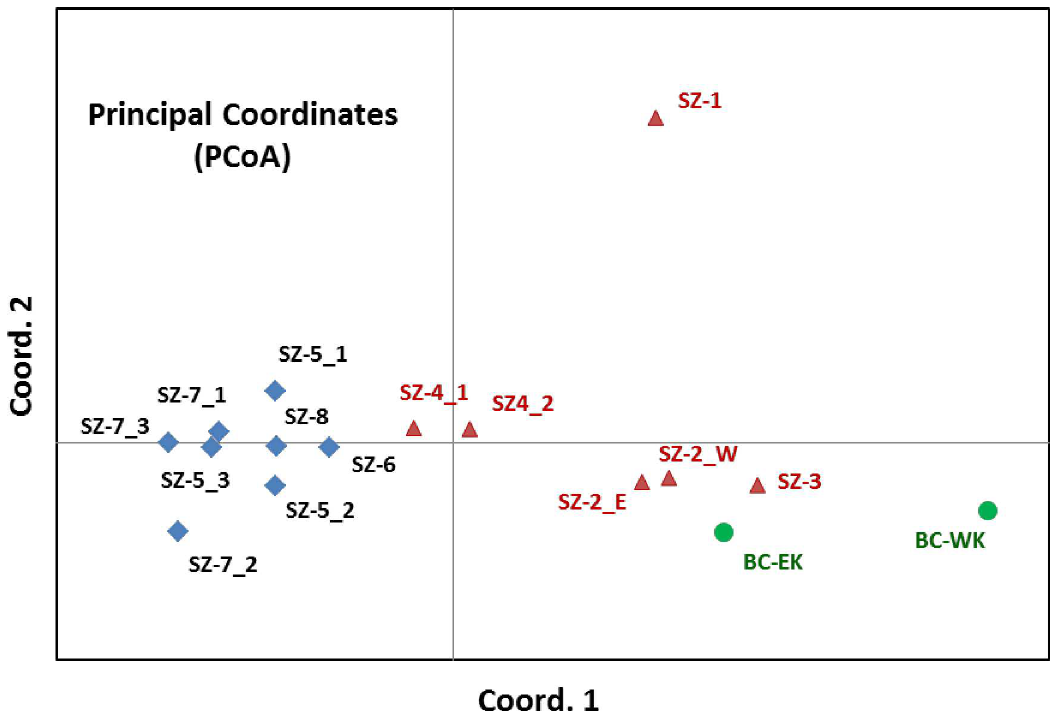
Fig 3. Principal coordinate analysis (PCoA) of whitebark pine populations using GenAlEx version 6.5. Seed zone (subzone)designations were listed in S1 Table. Three regionsare shown by colors, Green: British Columbia(BC), Canada; red: Washington State (WA); blue, Oregon state (OR), USA.